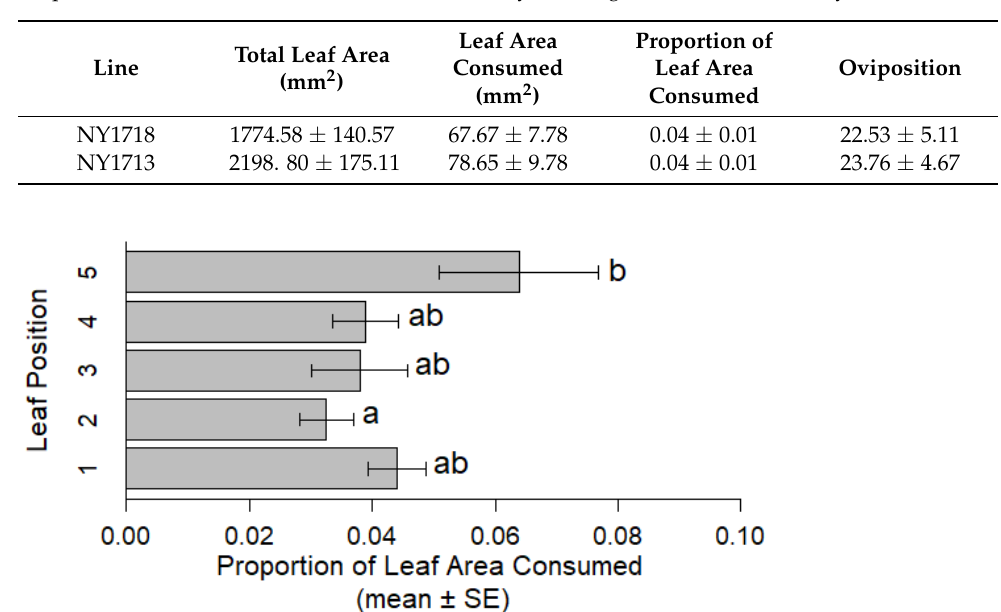
Table 2. Mean ( ± SEM) total leaf area, area consumed, proportion of area consumed, and oviposition by adult CRC on CRC-susceptible (NY1718) and CRC-resistant (NY1713) developmental populations.